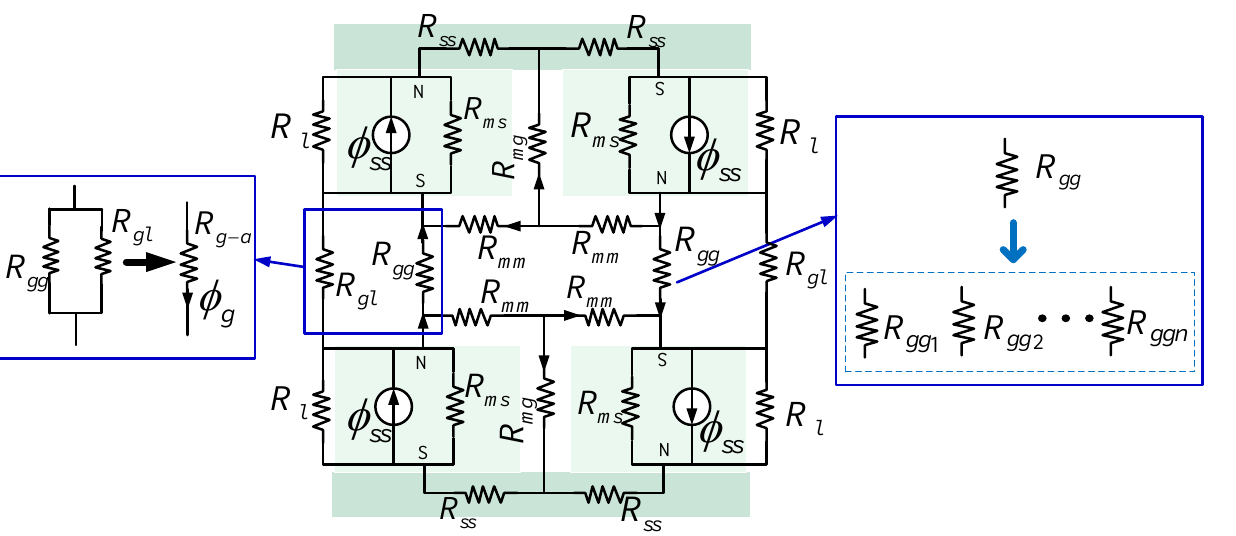
Figure 4. Conventional MEC of the LM stator.